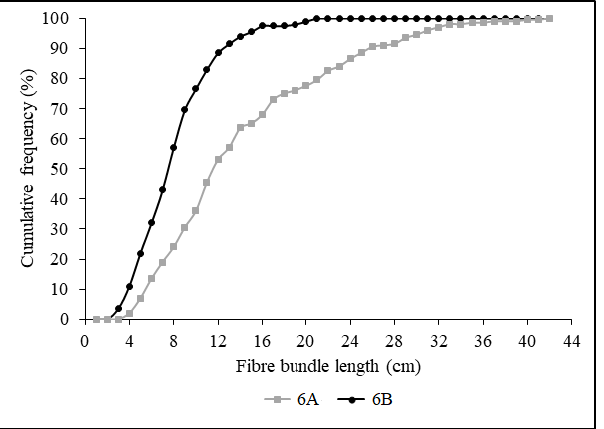
Figure 2. Frequency distribution curve of the length of fibre bundles extracted from batch number 6 using the A and B extracting methodologies.